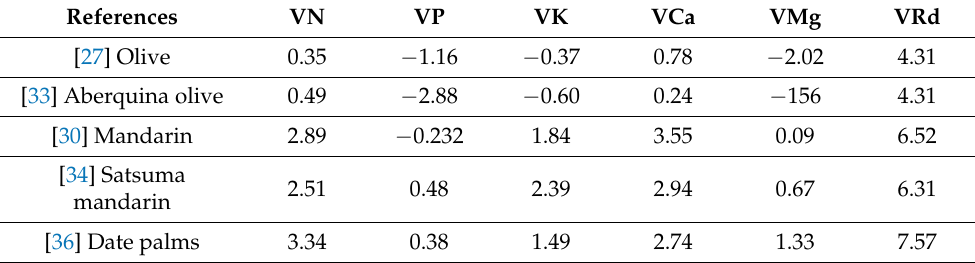
Table 7. CND standards for other fruits trees according to other publications.